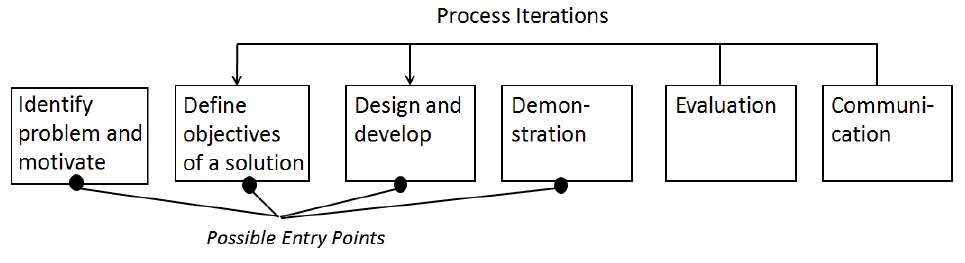
Figure 3. A design science process model adapted in a simplified form from [4]